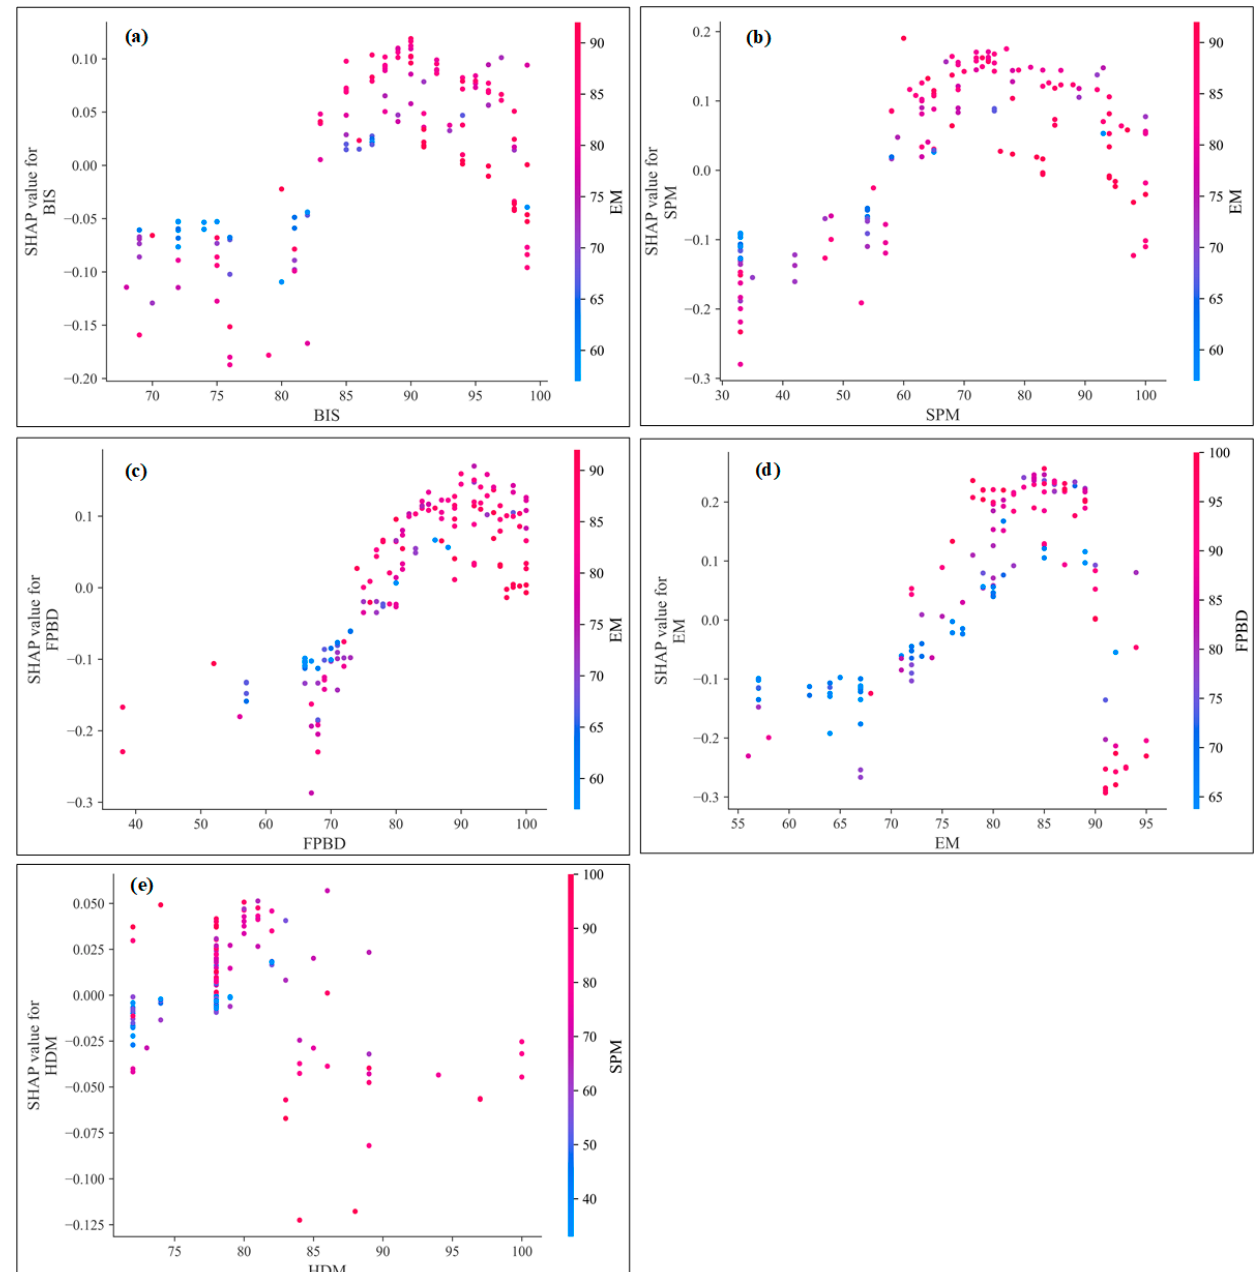
Figure 7. SHAP dependency plots for Safety mode of the fire risk database of stadiums.